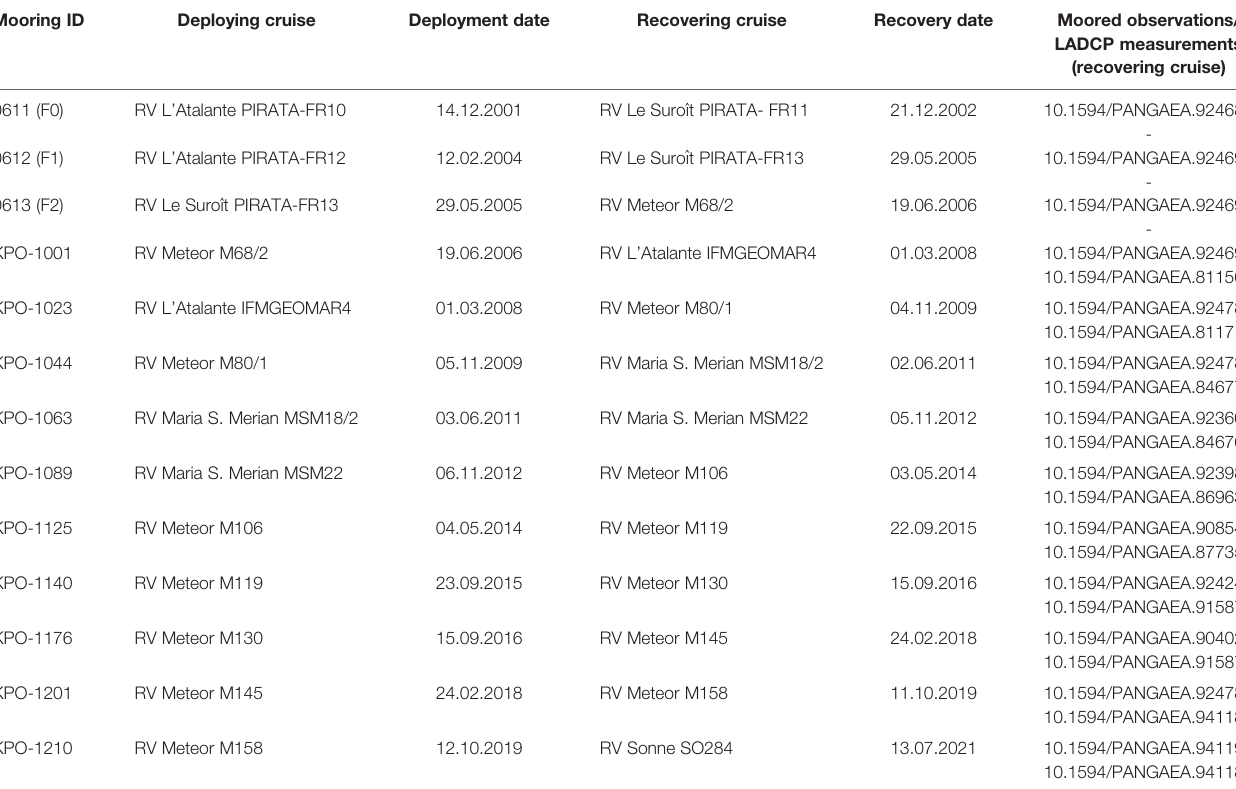
TABLE 1 | List of the subsurface moorings at 0°N, 23°W as well as the deploying and recovering research cruises, and the start and end dates of the individual mooring periods. Mooring